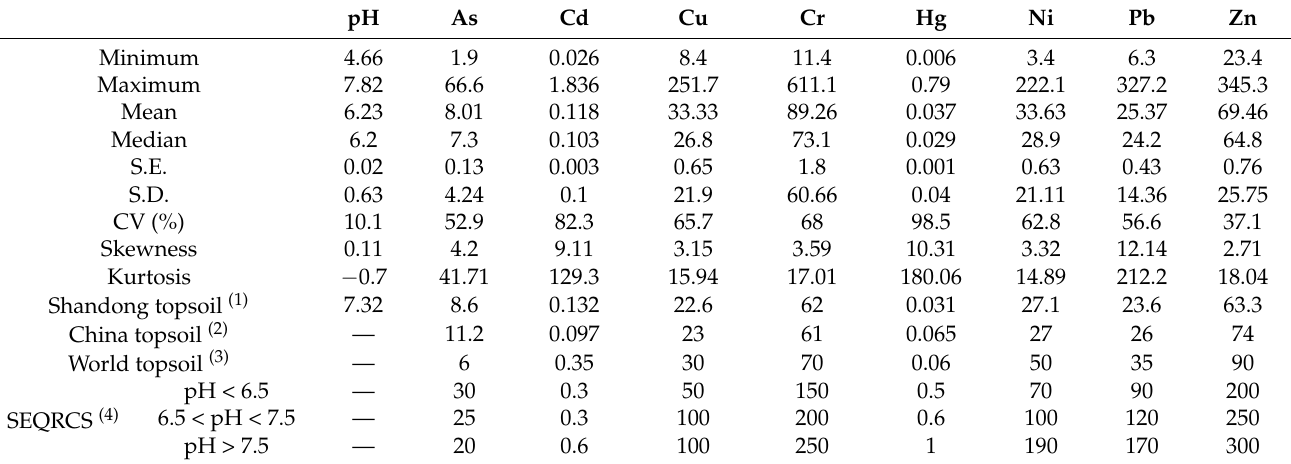
Table 3. Heavy metal concentrations in surface soils (N = 1135) (mg kg − 1 ).